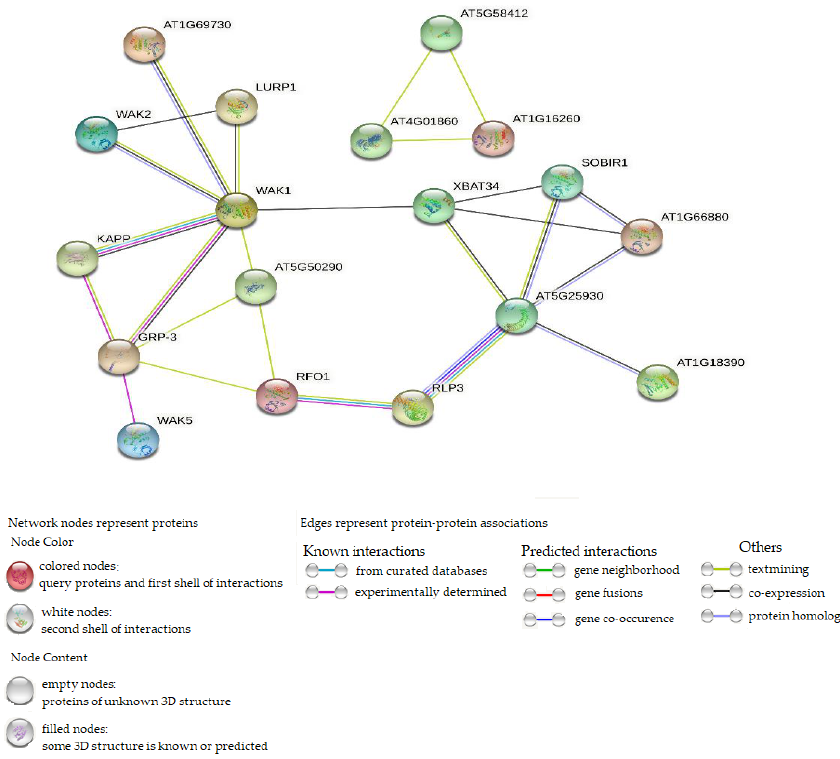
Figure 9. Protein–protein interaction of CsWAK/CsWAKL and Arabidopsis WAK/WAKL ortholo- Figure 9. Protein – protein interaction of CsWAK/CsWAKL and Arabidopsis WAK/WAKL ortholo- gous, setting the network edges as gous, setting the network edges as evidence.